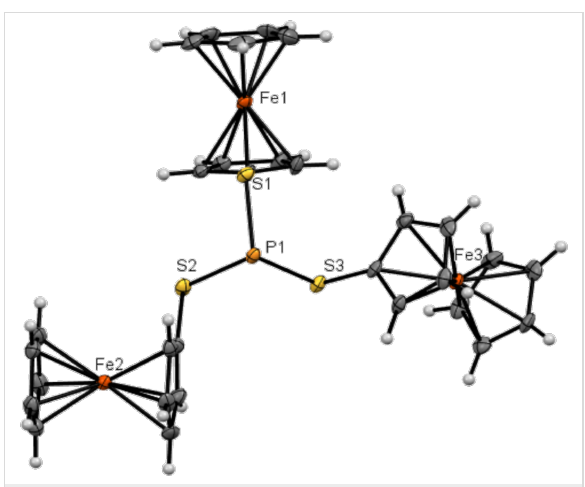
Figure 1: ORTEP representation of triferrocenyl trithiophosphite showing 50% probability thermal ellipsoids.